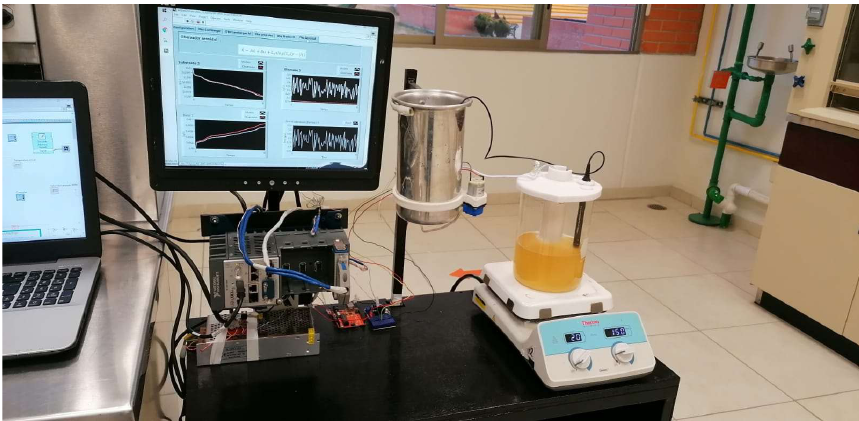
Figure 9. Implementation of observation strategies in the prototype plant. The trajectories of each state observer (solid lines) were extracted from the NI cRIO 9030 and imported into MATLAB. In addition, a comparison with the experimental data was performed. Figure 10 shows the performance of each state observer.